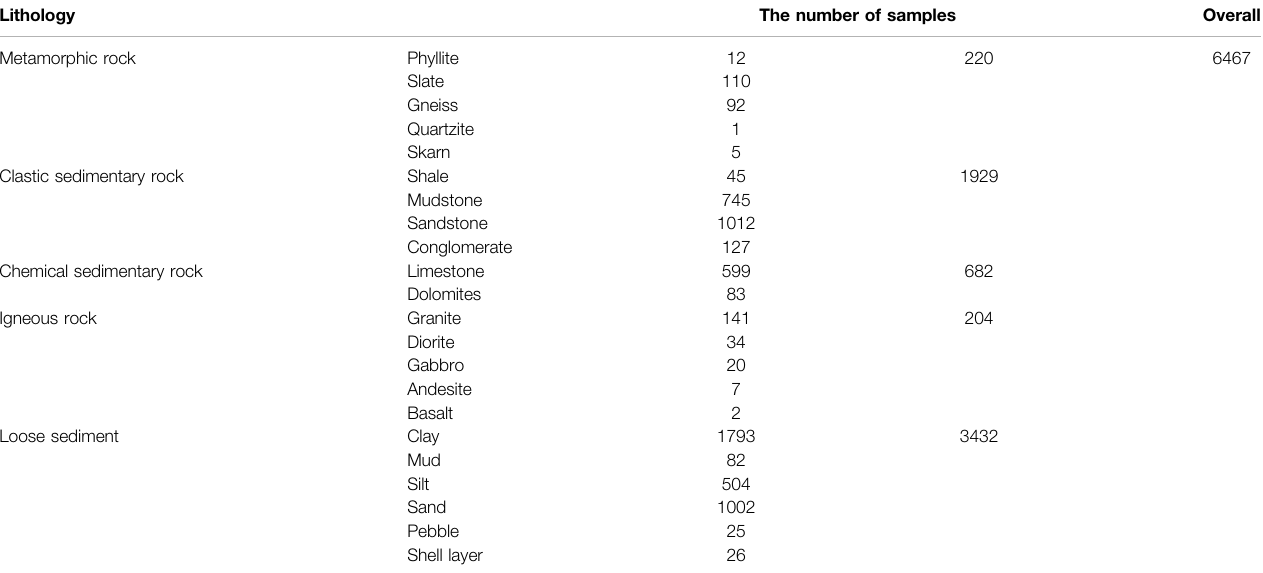
TABLE 2 | Lithology classi fi cation and number of